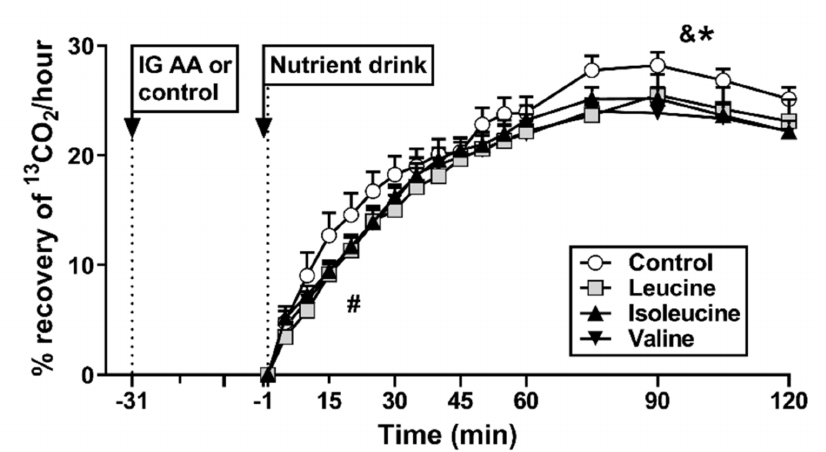
Figure 3. Recovery of 13 CO 2 in breath samples as a measure of gastric emptying of a mixed- nutrient drink, containing 100 mg 13 C-acetate, consumed at t = − 1 min, 30 min after intragastric (IG) administration of either 10 g of leucine, 10 g of isoleucine, 10 g of valine or control. Gastric emptying was expressed as AUC 0–120 min and AUC 0–30 min . * Leucine AUC 0–120 min significantly different from control, p < 0.05, & trend for valine to differ from control, p = 0.051. # Trend for an effect of treatment on early gastric emptying (i.e., t = 0–30 min post-drink), p = 0.096. Data are means ± SEMs; n = 15; AA, amino